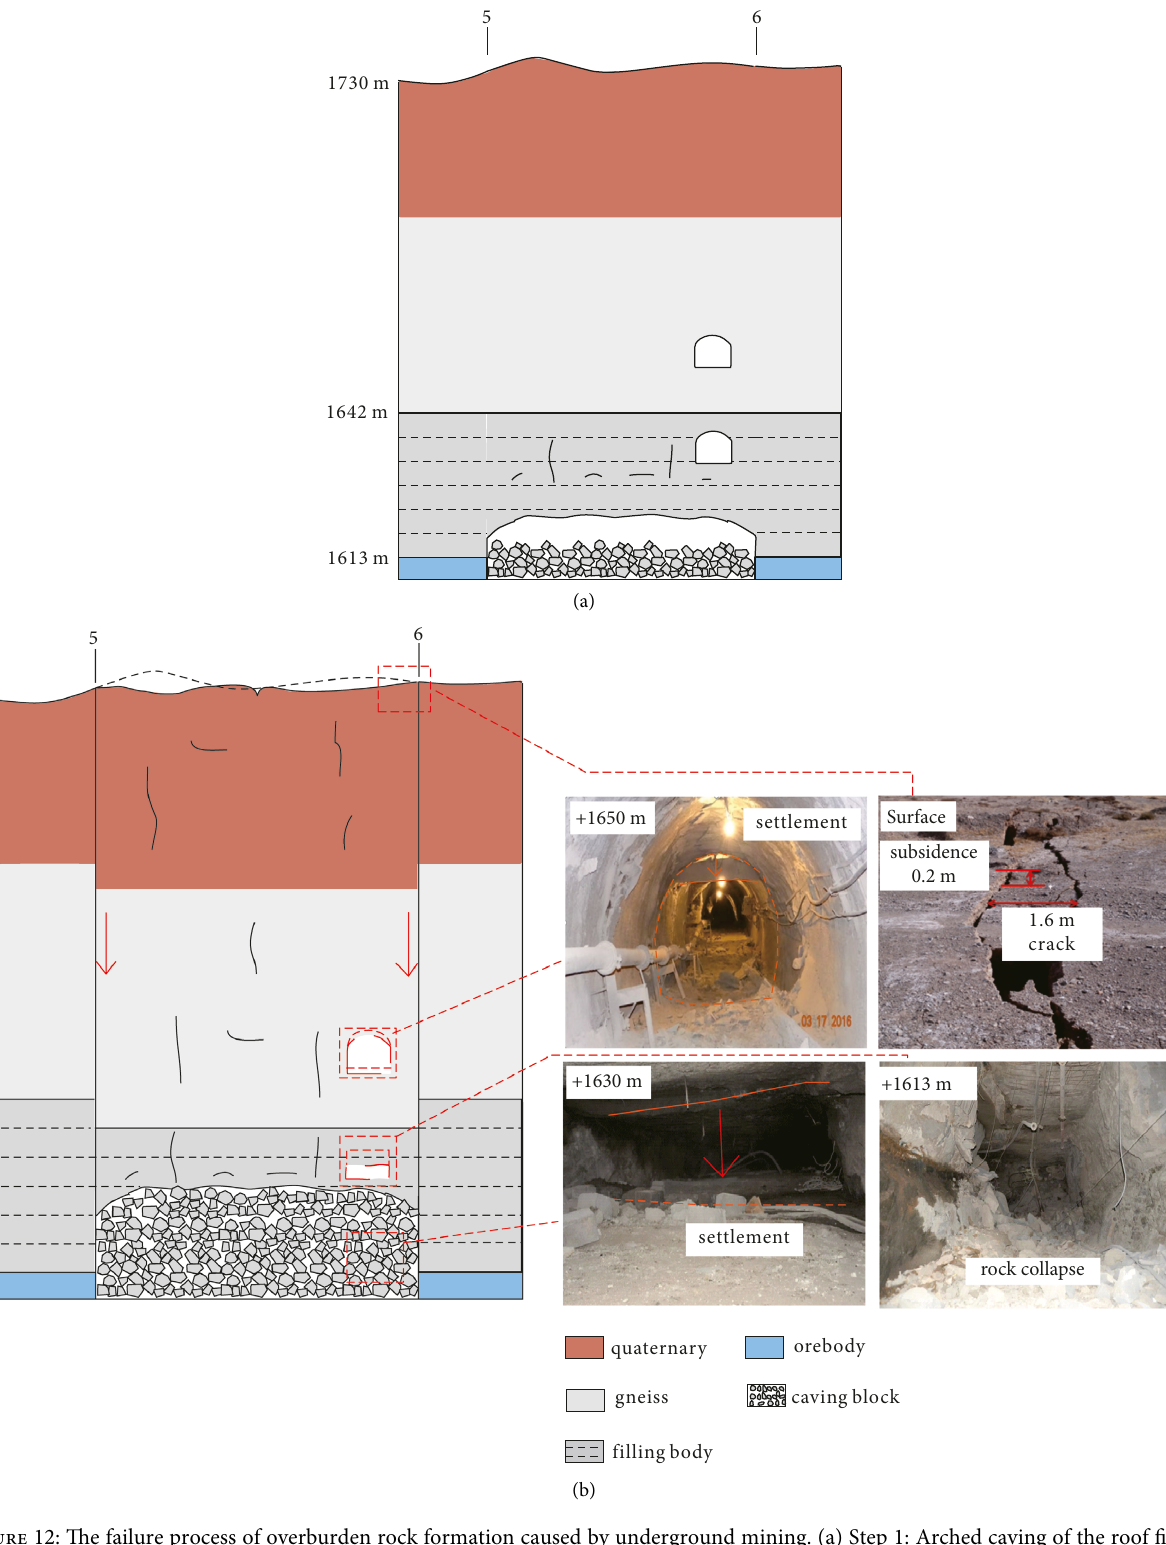
Figure 12: The failure process of overburden rock formation caused by underground mining. (a) Step 1: Arched caving of the roof filling body. (b) Step 2: Plug-subsidence of the upper